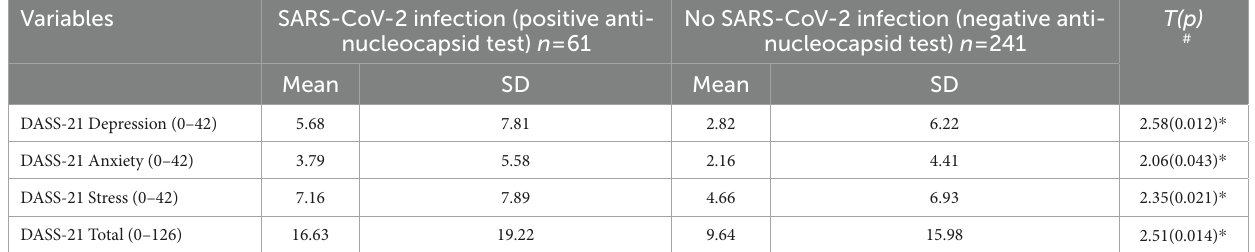
TABLE 3 Comparing depression, anxiety and stress (DASS-21) for study participants (t 1 and t 2 ) between those with and without confirmed SARS-CoV-2 infection in 2021 ( n = 305).